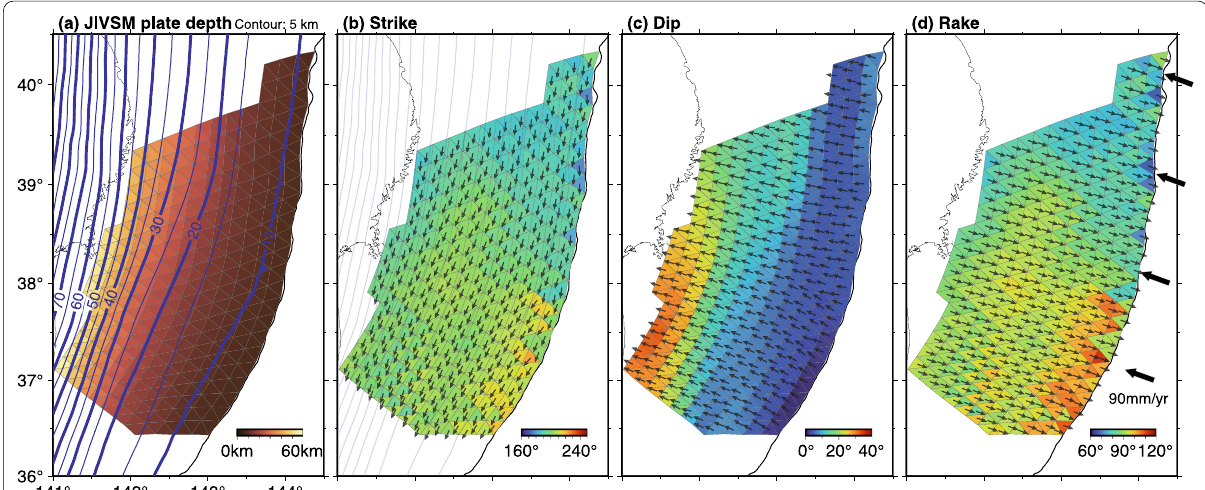
Fig. 2 Configuration of the subfaults used in this study. a Center depths of the subfaults measured from the sea surface. Depth contour of the plate boundary of JIVSM (Koketsu et al. 2012) is also shown, with an interval of 5 km for thin lines and 10 km for thick lines. b Strike angles of the triangular subfaults. Strike direction is shown by small arrows. c Dip angles of the triangular subfaults. Dipping direction is shown by small arrows. d Rake angles of the triangular subfaults. Direction of the plate convergence (DeMets et al. 2010) is also shown by thick arrows